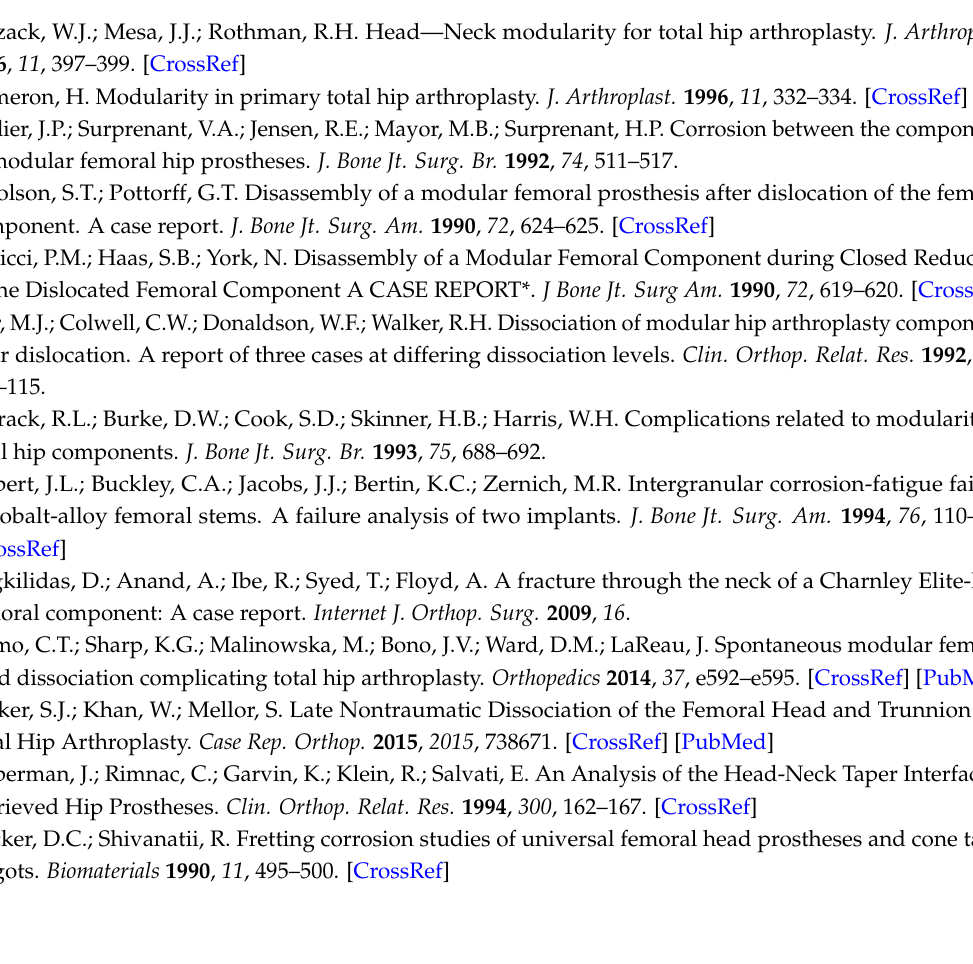
Table S1: Clinical information, design parameters and DRF for the 148 retrieved implants clustered on the basis of the HNJ damage